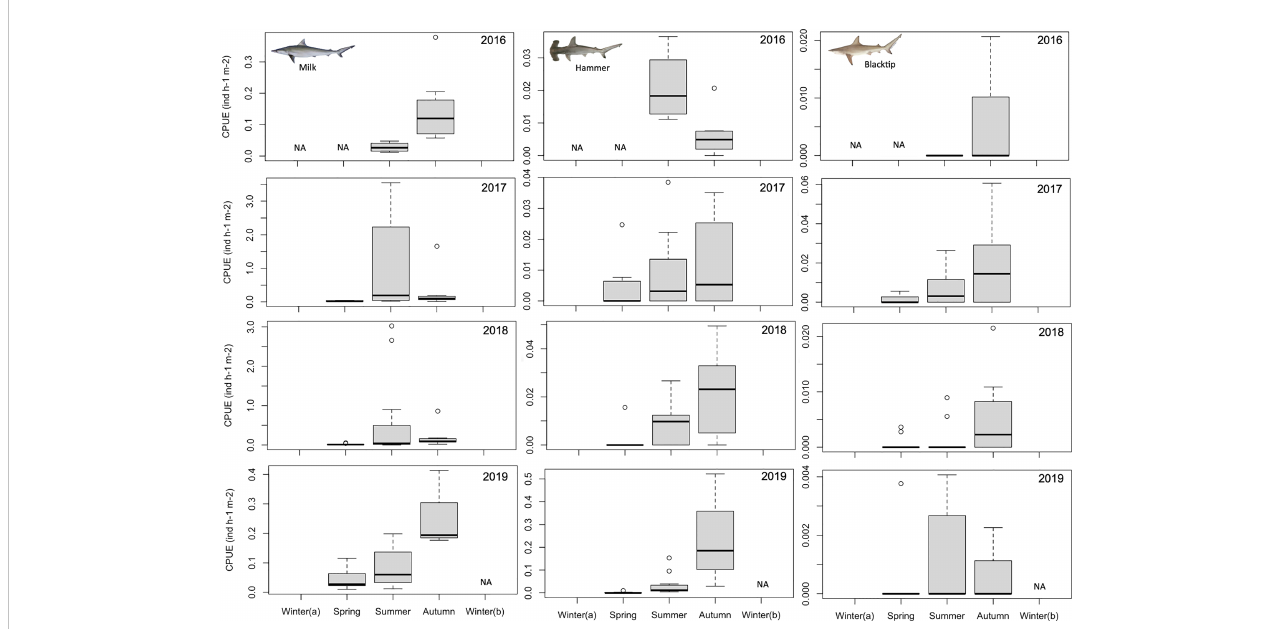
FIGURE 1 Temporal changes in the relative abundance (catch per unit of effort; number of individuals h -1 m -2 ) of juvenile milk ( Rhizoprionodon acutus ), scalloped hammerhead ( Sphyrna lewini ), and blacktip ( Carcharhinus limbatus ) sharks in Sal Rei Bay, Boa Vista Island, Cabo Verde. NA, not